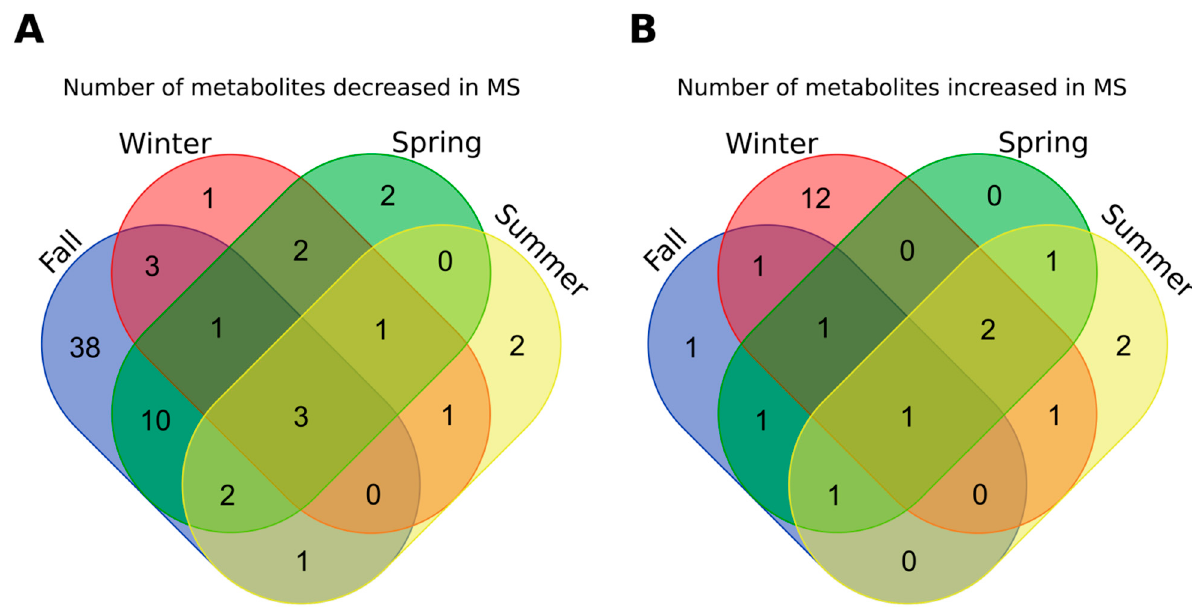
Figure 3. Venn diagram illustration of metabolites affected in MS. ( A ) Decreased metabolites in MS compared to control; ( B ) increased metabolites in MS compared to